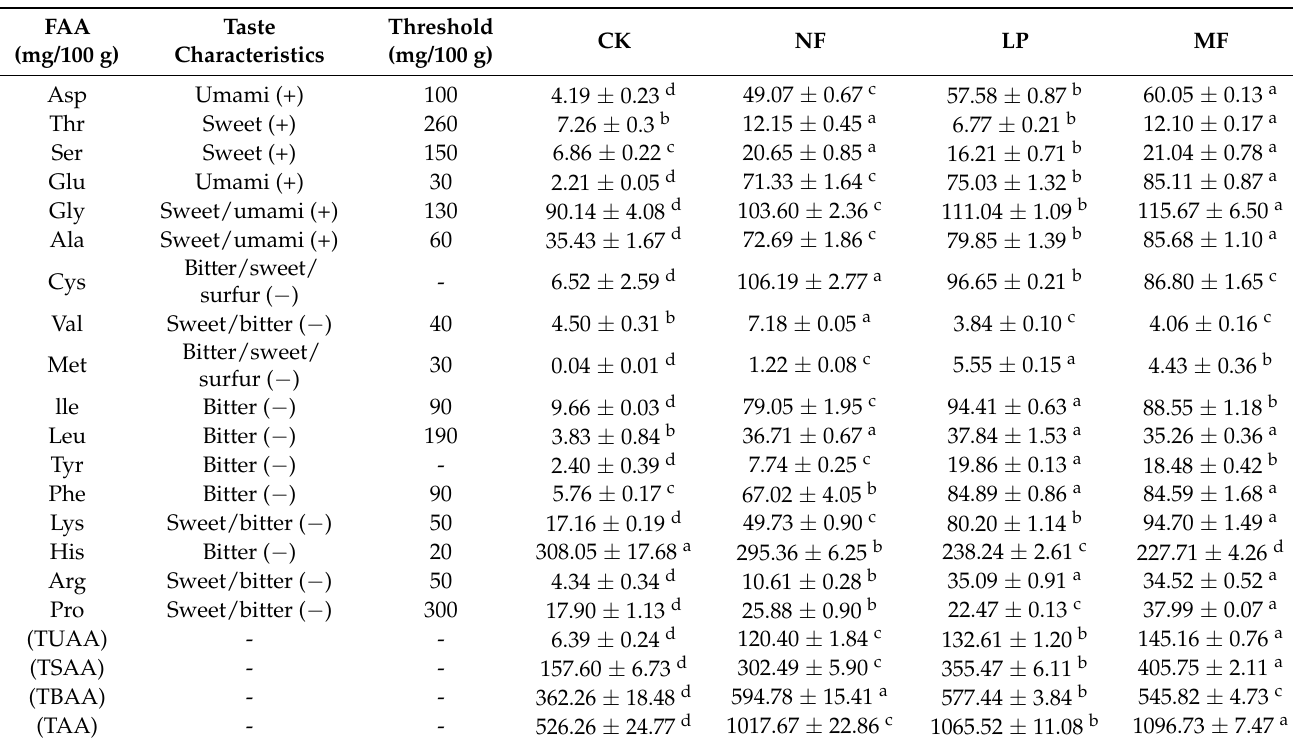
Table 2. The contents of free amino acids in different fermented Suanyu samples at 15 days (mg/100